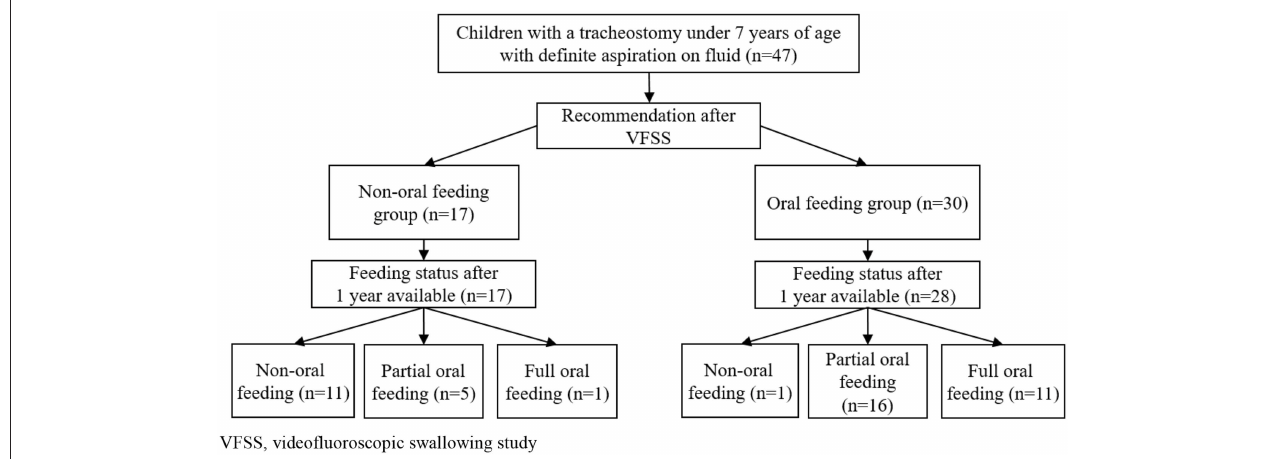
FIGURE 1 | Flowchart of children with tracheostomy younger than 7 years of age with definite fluid aspiration confirmed via VFSS. VFSS, videofluoroscopic swallowing study.